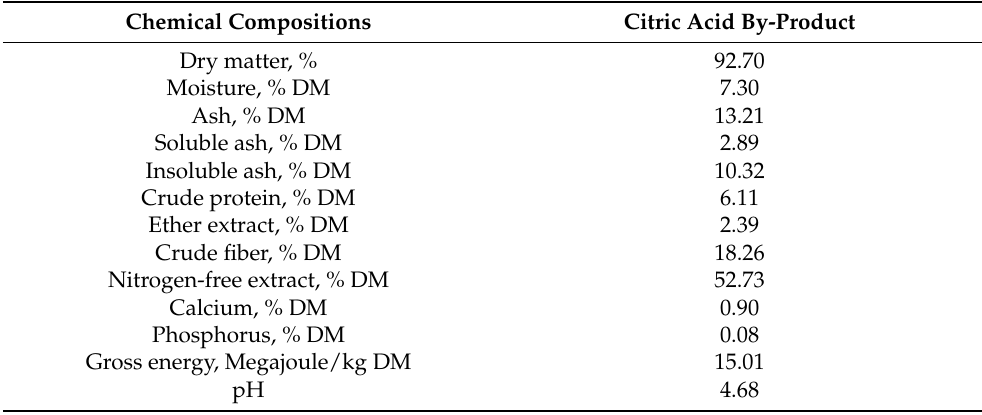
Table 1. Nutrient composition of citric acid by-product from